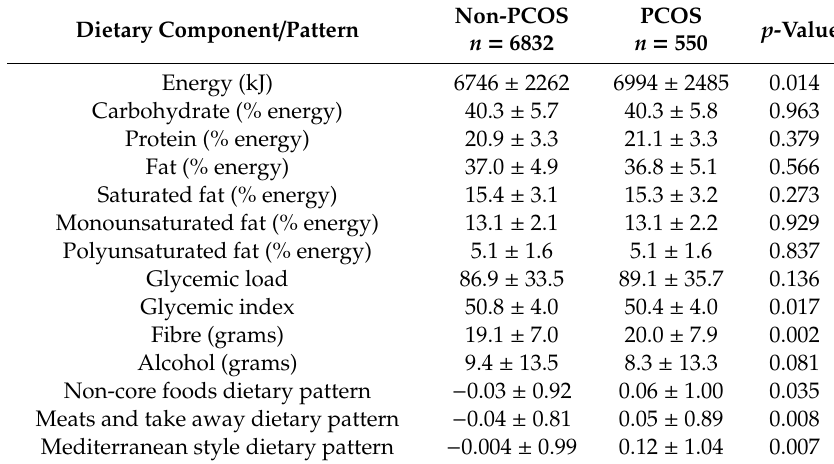
Table 2. Dietary intake in women with and without PCOS. Dietary Component / Pattern